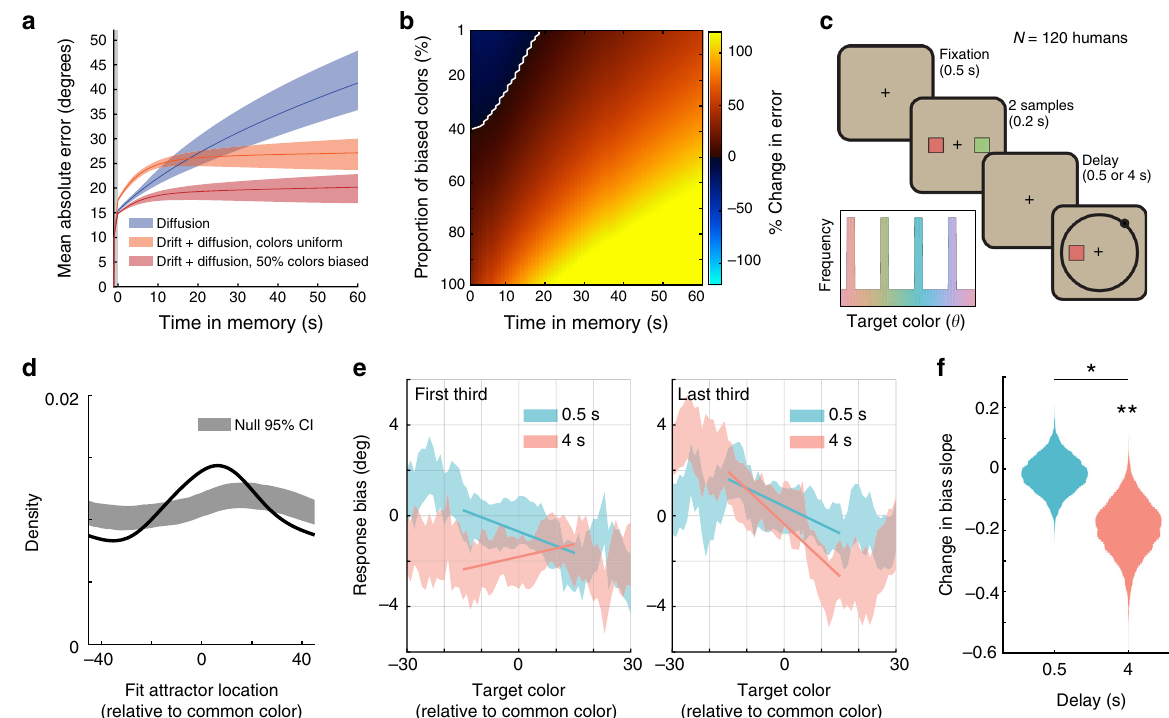
Fig. 7 Attractor dynamics adapt to the context. a Simulated mean absolute error in the representation of the target color over time. The best- fi tting discrete attractor model in Experiment 1a ( ‘ drift + diffusion ’ ; orange and red) is compared to the same model without encoding or memory drift ( ‘ diffusion ’ ; blue). Error is simulated for two target distributions: one in which targets were sampled uniformly (colors uniform) and one in which 50% of targets were drawn more frequently from colors near attractors. Note that the performance of the diffusion model does not depend on the distribution of target colors. Results are based on the mean parameter fi ts for the high load condition; similar results were observed for low load. Shaded regions re fl ect variability across subjects (95% CI). b Percent increase in simulated error for diffusion model compared to full ‘ drift + diffusion ’ model as a function of time in memory ( x - axis) and the degree of bias in the target distribution ( y -axis). Warm colors indicate attractors reduce memory error; white line indicates no change. c Experiment 2. Humans ( N = 120) performed a color delayed estimation task with two stimuli. Inset: Example color distribution for one subject. Four groups of colors were presented more frequently. Common colors were equally spaced in color space and differed for each subject. d Probability of attractor position (estimated from dynamical model fi ts) relative to common colors (black). Shaded region indicates 95% con fi dence intervals of the null distribution, based on randomly permuting the location of common colors across subjects. e Bias for targets around common colors during the fi rst and last third of trials, with regression lines. Error bars re fl ect standard error of the mean. f Difference in the slope of bias at common colors between the fi rst third and last third of trials for short and long-delay trials. Distributions re fl ect bootstrapped values. * p < 0.05, ** p < 0.01, bootstrap. Source data are provided